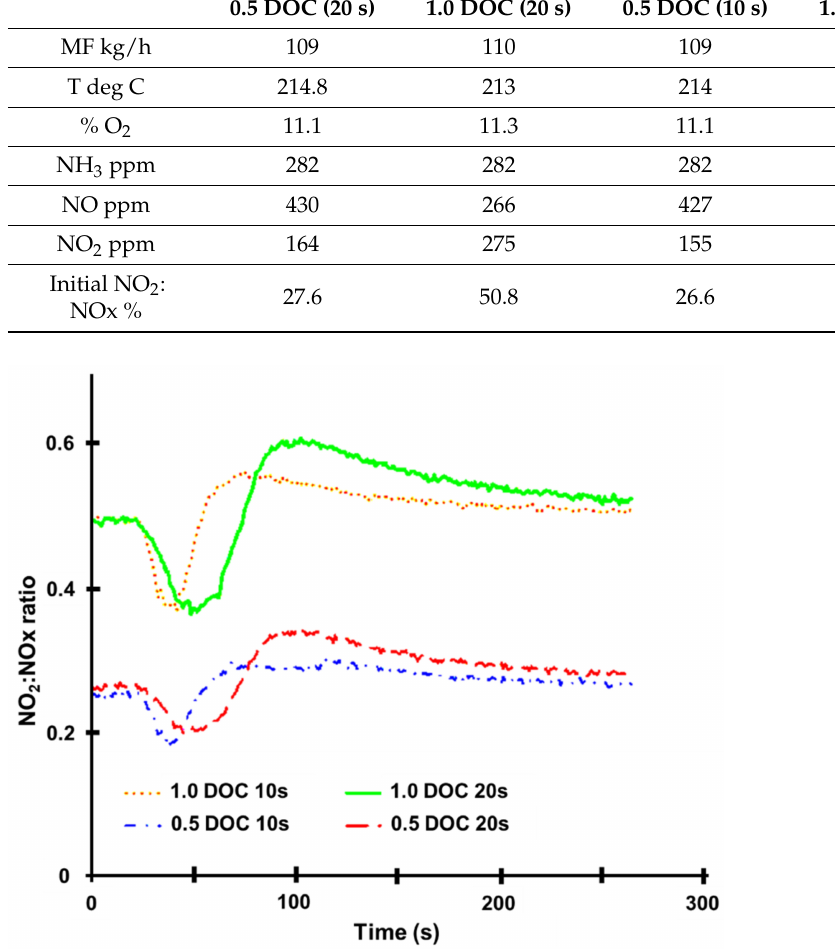
Figure 10. NO 2 :NOx ratios from the 2000 cc diesel engine tests, adapted from Benjamin et al. [82].